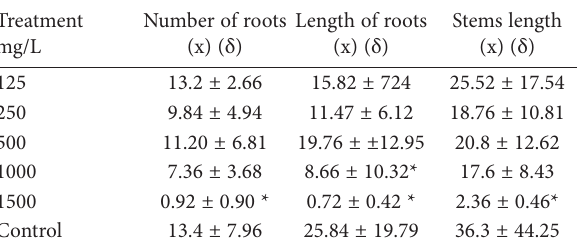
Table 1. Number and length of roots, and stem length of A. sativum exposed to the ethanol extract of Sambucus canadensis.